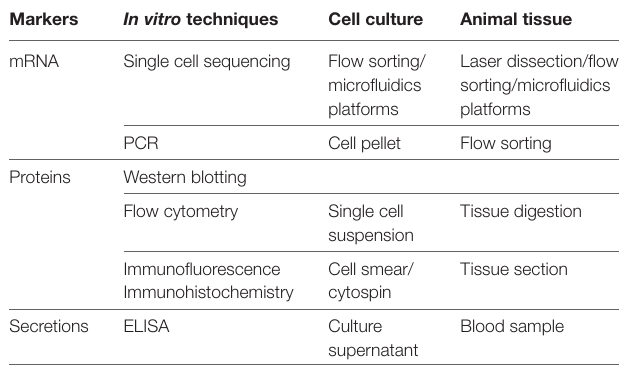
Table 1 | Molecular biology and histological techniques for macrophage study in vitro . Markers In vitro